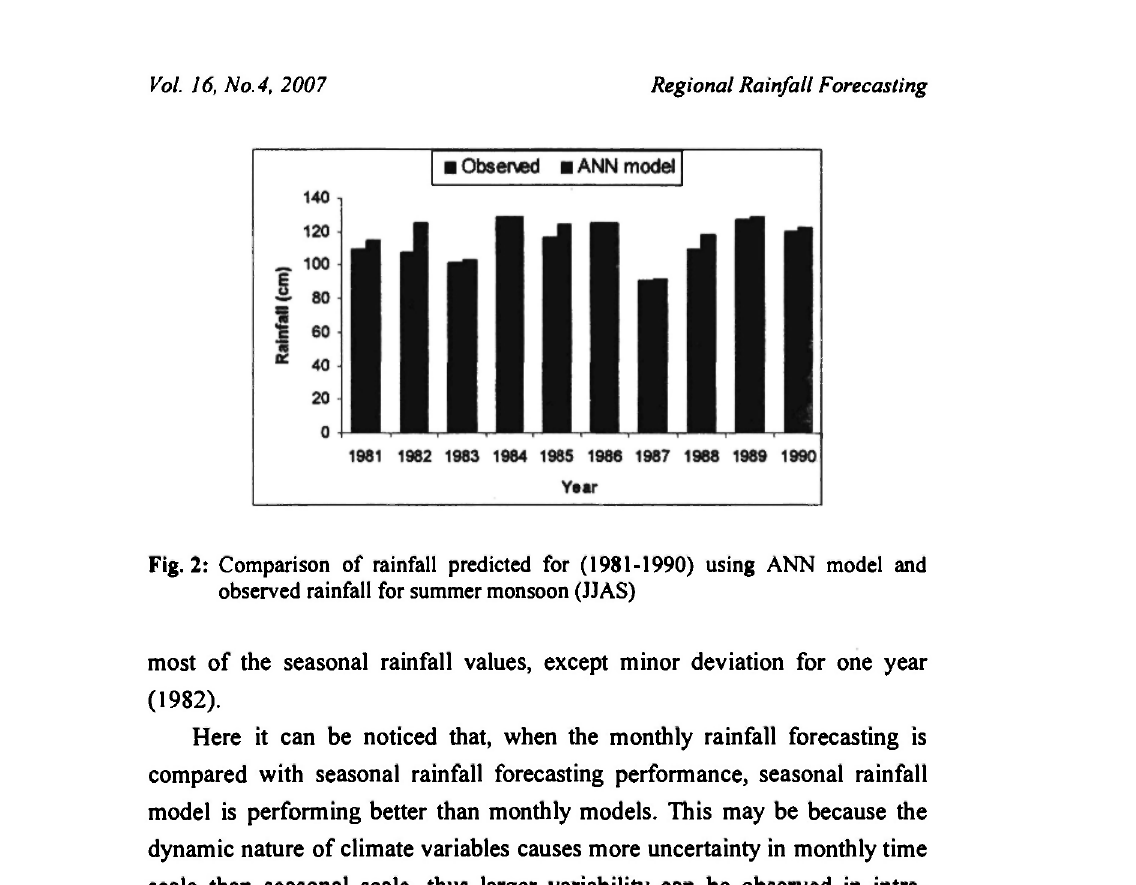
Fig. 2: Comparison of rainfall predicted for (1981-1990) using ANN model and observed rainfall for summer monsoon